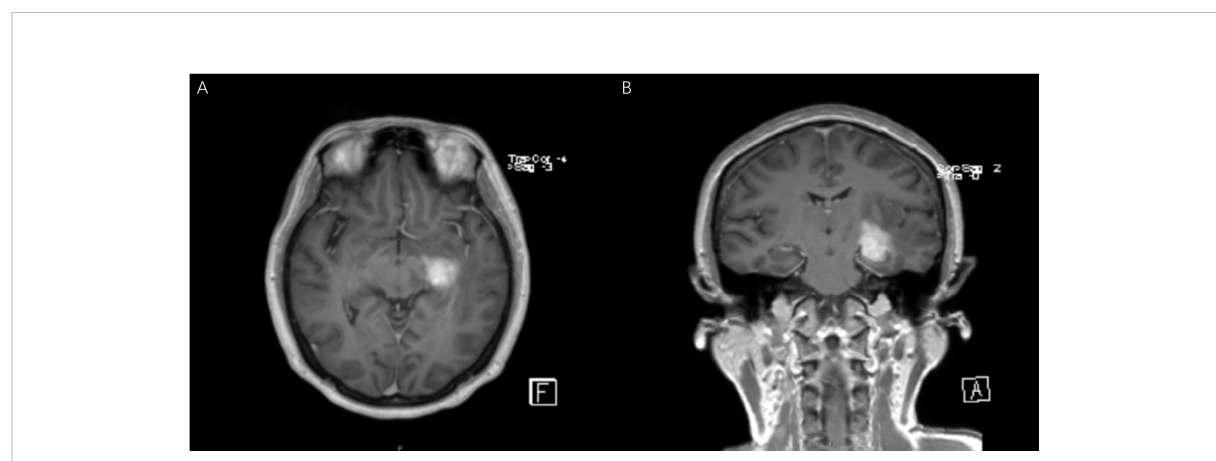
FIGURE 2 Patient No.12 is a 54-year-old female with a main complaint of dizziness. The coronal (A) and axial (B) MR T1 weighted images showed a 2.2×1.7×1.5cm abnormal signal shadow in the left temporal insula. The initial diagnosis was